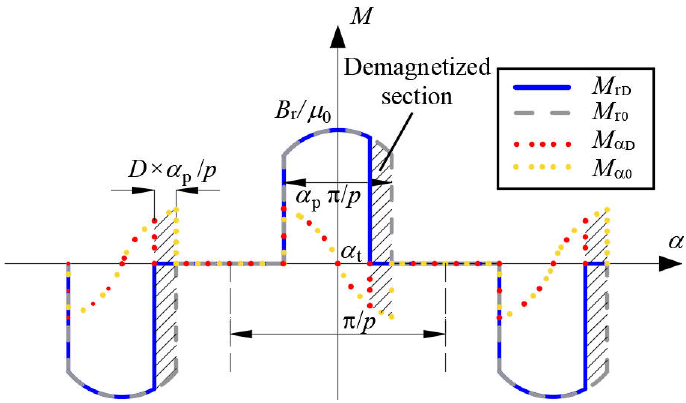
Figure 4. Magnetization of healthy PMs and uniformly demagnetized PMs (parallel magnetization). The Fourier decomposition of the radial component of the magnetization of uni-